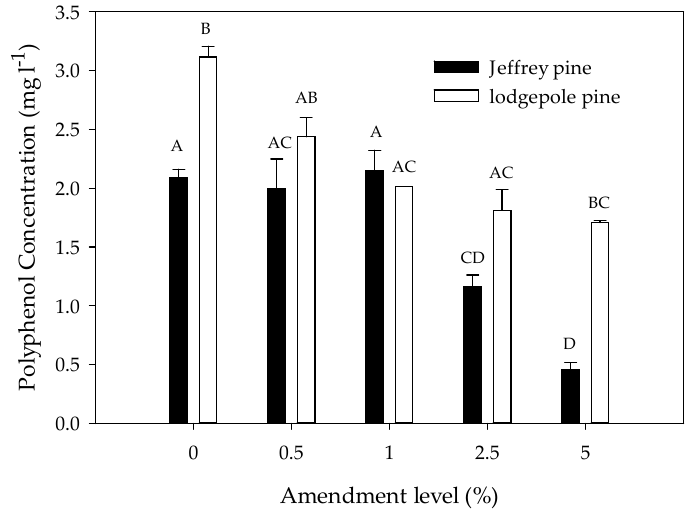
Figure 2. Polyphenol concentration in soil extracts as a function of charcoal amendment level (% by mass) in Jeffrey pine and lodgepole pine soils. Error bars represent standard error of the mean polyphenol concentration ( n = 3). Different letters indicate significant differences ( p < 0.05) across soil types and amendment levels.